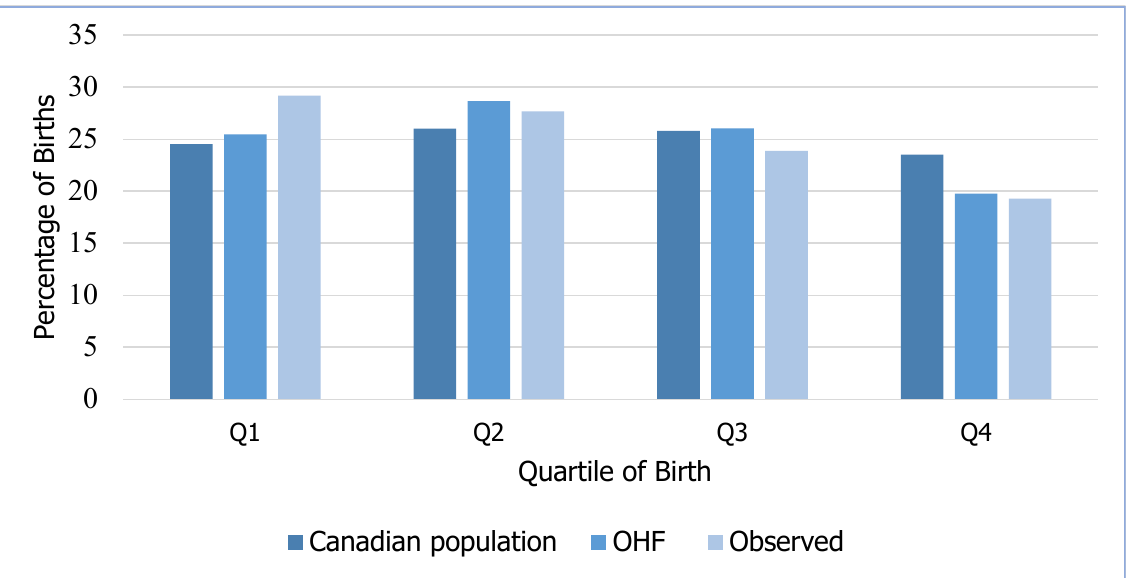
Figure 1. Expected distributions were derived from the Human Fertility Database in Canada between 2000 and 2002, and Ontario Hockey Federation (OHF) birthrates for “midget” girls (Hancock, 2017).